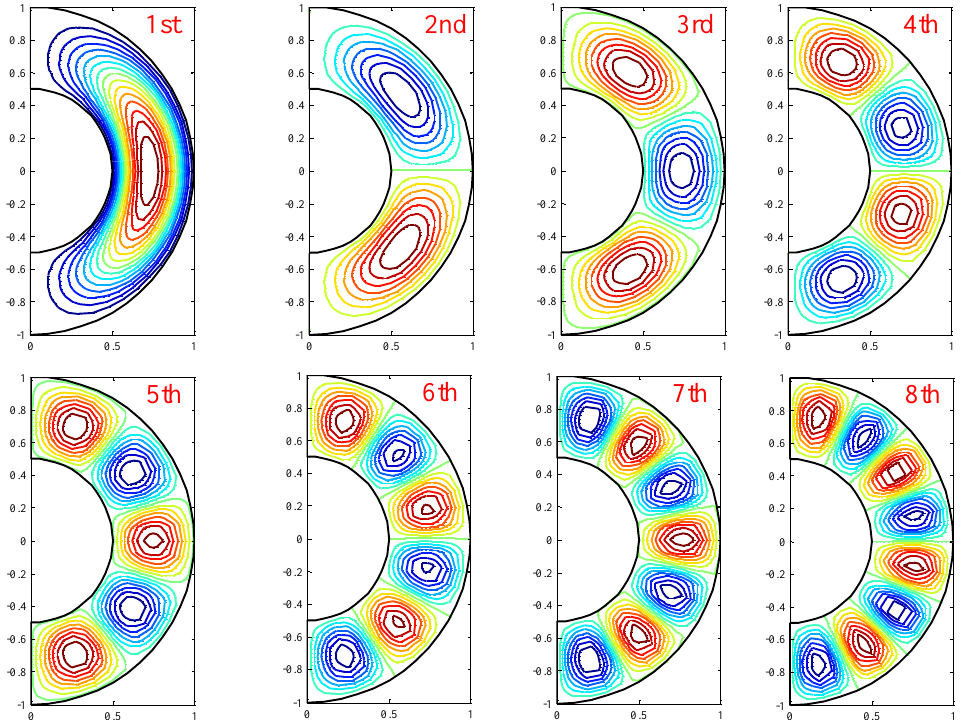
Figure 6: The lowest eight mode shapes for a [0 ∘ /90 ∘ /90 ∘ /0 ∘ ] laminated annular sector plate with CE 3 CE 3 boundary conditions( E 1 / E 2 =15, a / b =0.5, h / b =0.1, ϕ = π